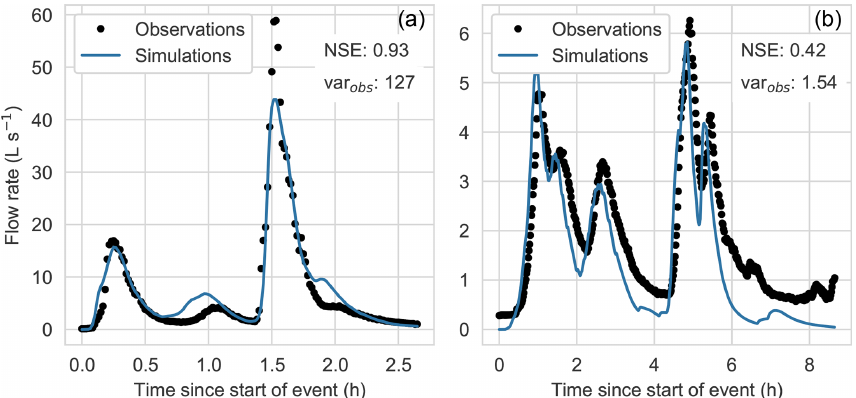
Figure 2. Examples of hydrographs for events with high (a) and low (b) objective function (NSE) values; var obs denotes the variance of the